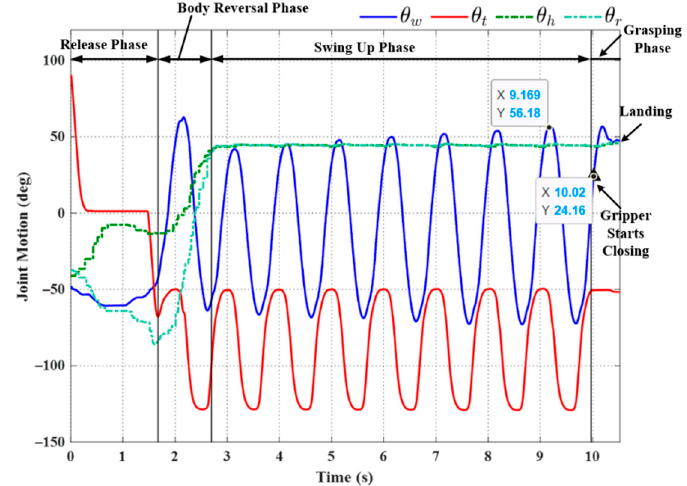
Figure 21. Experimental results: joint motion in Experiment (f).